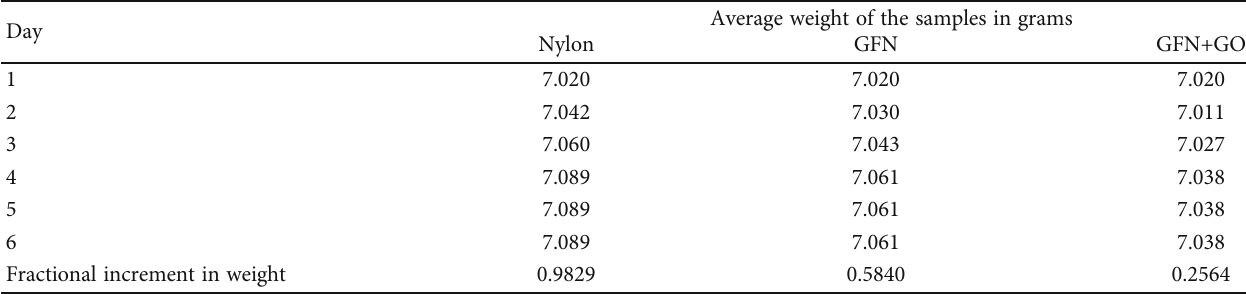
Figure 8: Thermogravimetric analysis of GO-GFN hybrid nanopolymer. Table 4: Water absorption